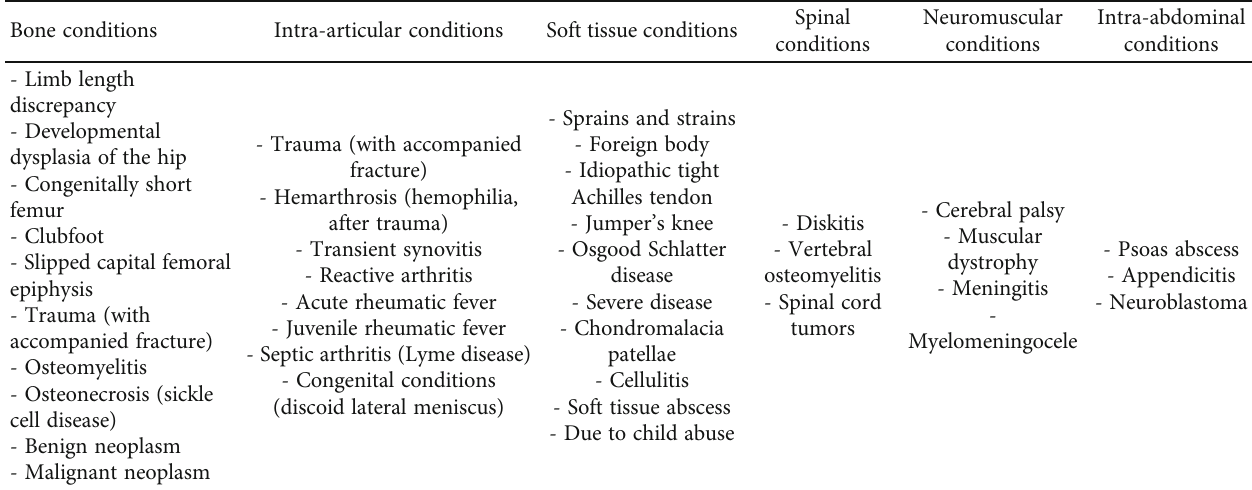
Table 1: Broad di ff erential diagnoses in the limping child. A detailed history and physical examination, appropriate laboratory tests, and imaging are essential for making a correct